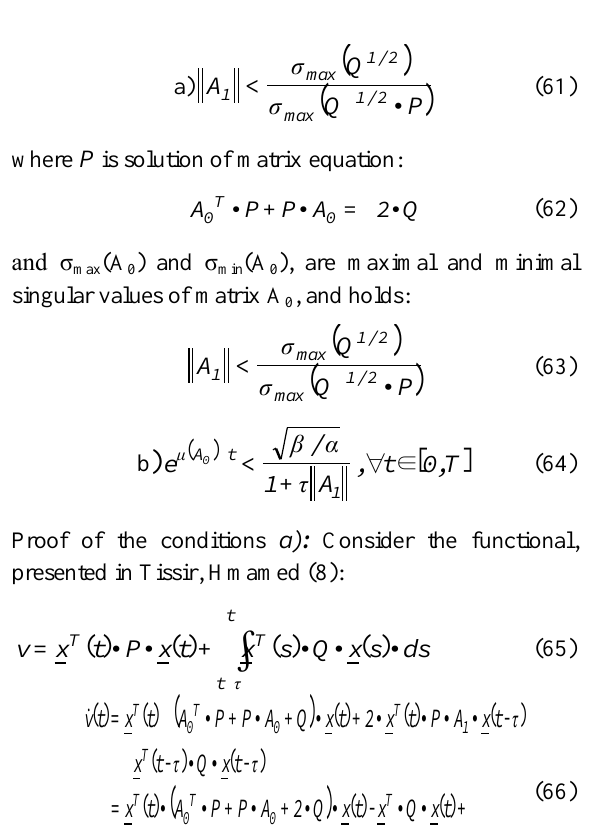
Figure 2. System motion on time interval and space interval z € [0,